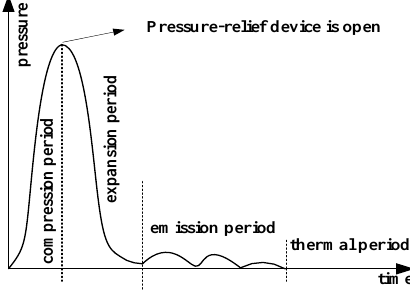
Figure 2. Different stages of the pressure rise before and after the pressure relief device is open.